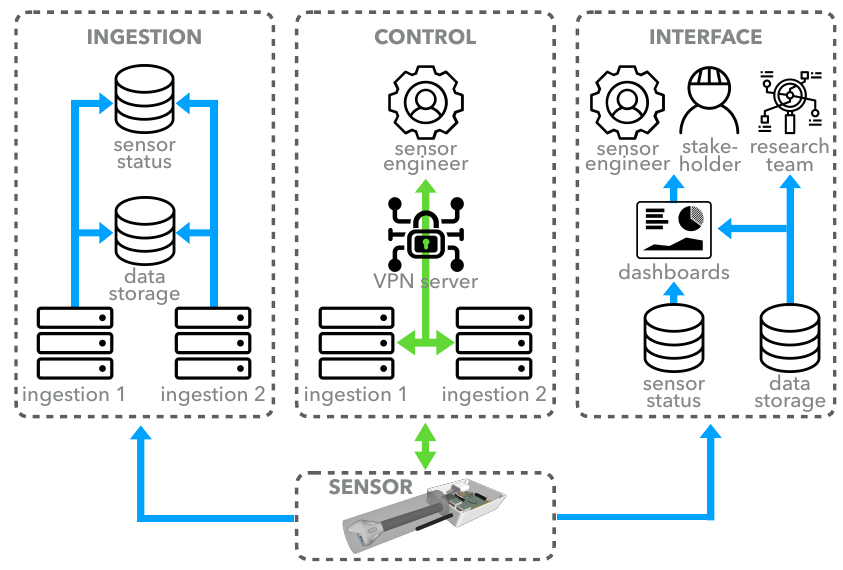
Figure 7. Infrastructure overview showing core system operations with data flow in blue and control flow in